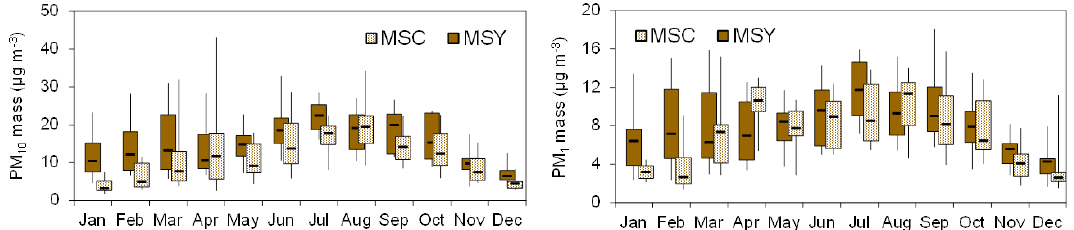
Figure 2. Monthly median (black line within the boxes) and percentiles (5–25–75–95, boxes and whiskers) of daily PM 10 and PM 1 mass concentrations at Montsec (MSC) and Montseny (MSY) based on daily measurements between January 2010 and March 2013.